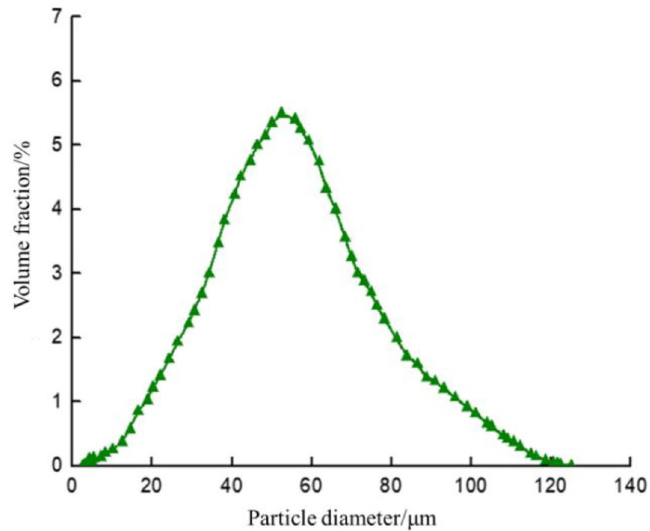
Figure 1. Particle size distribution of hollow glass